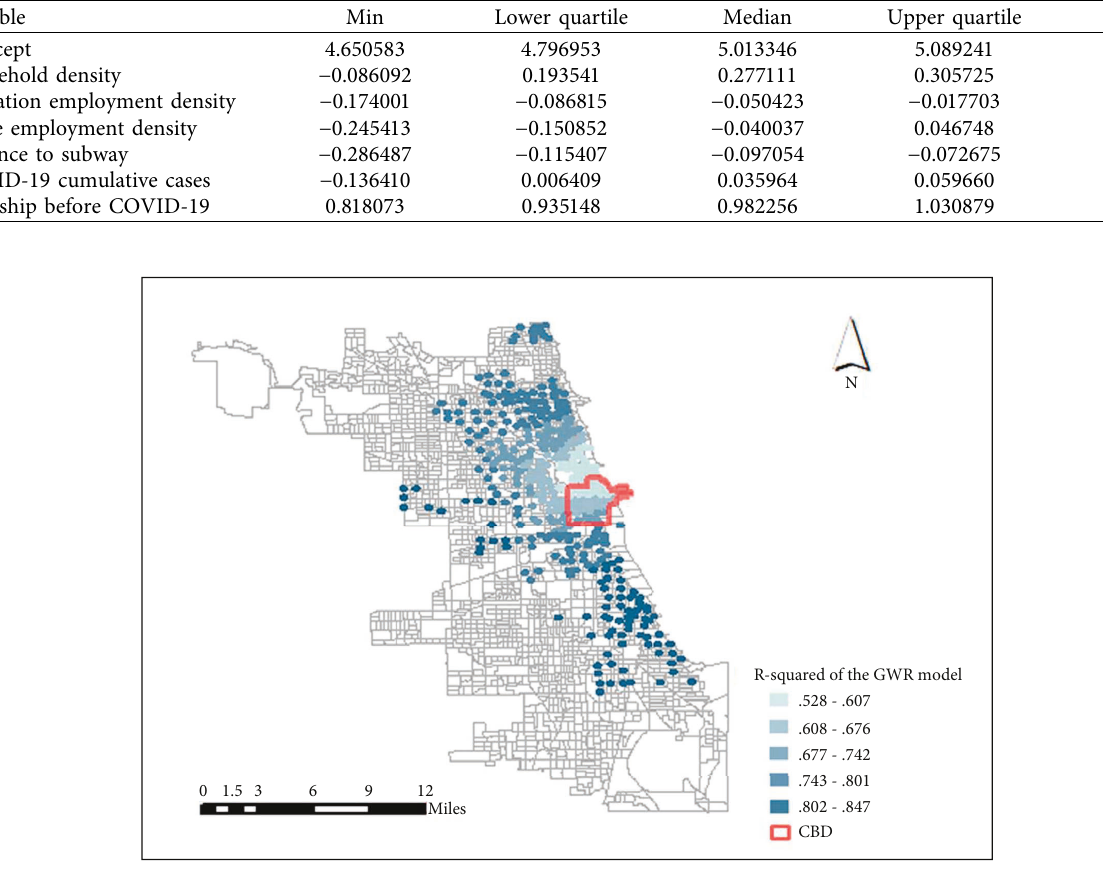
Figure 8: Spatial distribution of the R-squared of the GWR model. Table 6: Variable type